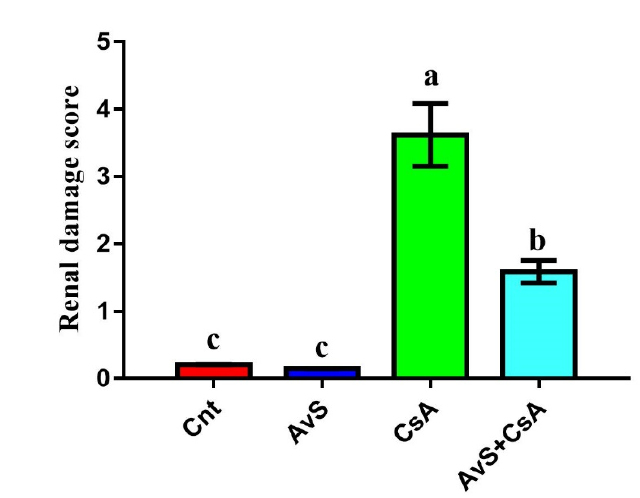
Figure 4. ( A – D ) Microscopic pictures of H&E-stained renal sections showing normal glomeruli, tubules, and interstitial tissue from the control ( A1 , 2 ) and AvS ( B1 , 2 ) groups; tubular dilation, perivascular edema (green arrowhead), hyaline cast (black arrow), pyknotic nuclei (red arrowhead), and widened Bowman’s space from the CsA group ( C1 , 2 ); and mild tubular dilation from the AvS + CsA group ( D1 , 2 ). Black arrowheads: glomeruli; blue arrows: Bowman’s space; yellow arrowheads: renal tubules. Scale bars: 100 µ m for ( A1 , B1 , C1 , D1 ); and 50 µ m for the remaining images. ( E ) Renal damage score; values are mean ± SEM ( n = 7/group). Columns with different letters (a–c) are significantly different at p < 0.05.